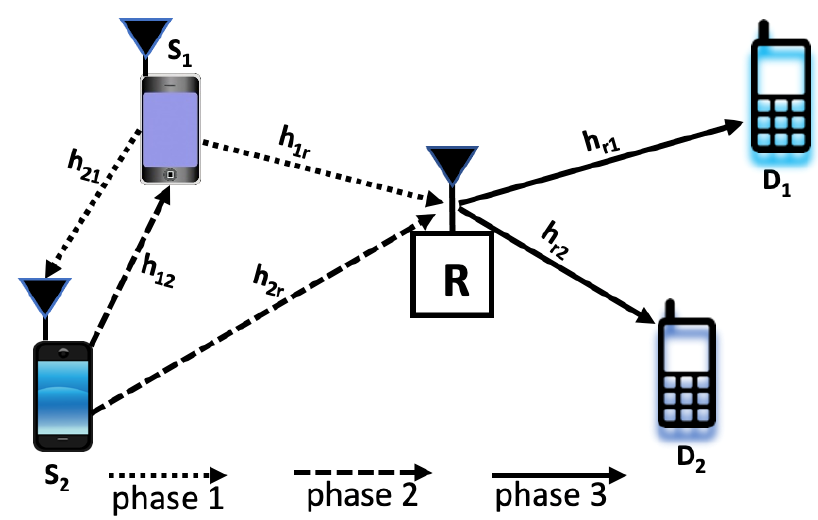
Figure 1. System